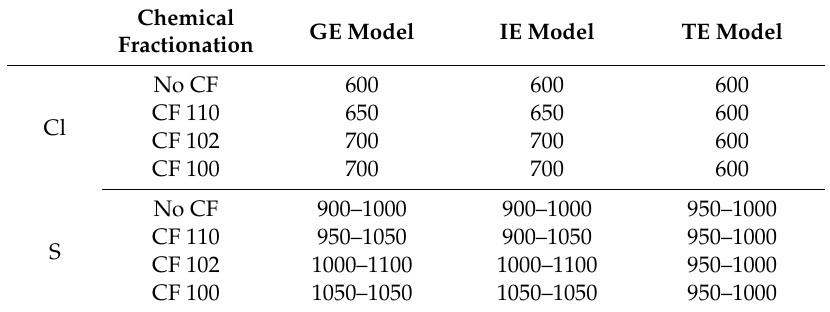
Table 2. Matching temperatures (°C) for the predicted and analytical Cl and S compositions in fly ashes. 1.